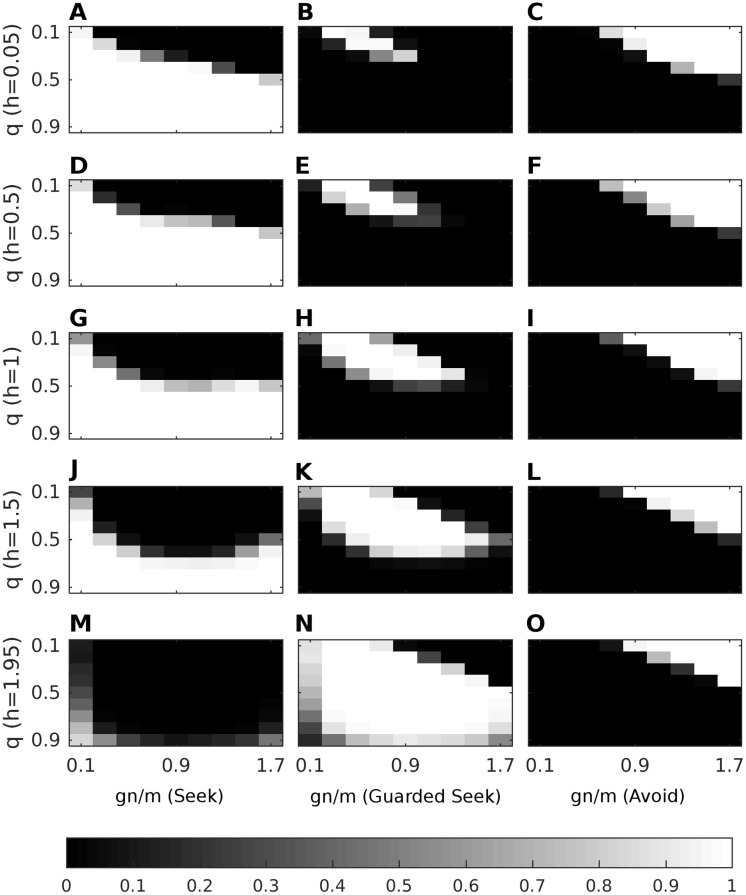
Heatmap of action selection, for various parameter configurations and a perfect generative model.Action selection proportions (black = 0, white = 1) per 4-step iteration of free energy minimisation (averaged over repetitions) for g = 2 and varying h (rows), m and n (x-axis) and q (y-axis). A: Proportions for Seek with h = 0.05. B: Proportions for Guarded Seek with h = 0.05. C: Proportions for Avoid with h = 0.05. D: Proportions for Seek with h = 0.5. E: Proportions for Guarded Seek with h = 0.5. F: Proportions for Avoid with h = 0.5. G: Proportions for Seek with h = 1. H: Proportions for Guarded Seek with h = 1. I: Proportions for Avoid with h = 1. J: Proportions for Seek with h = 1.5. K: Proportions for Guarded Seek with h = 1.5. L: Proportions for Avoid with h = 1.5. M: Proportions for Seek with h = 1.95. N: Proportions for Guarded Seek with h = 1.95. O: Proportions for Avoid with h = 1.95.